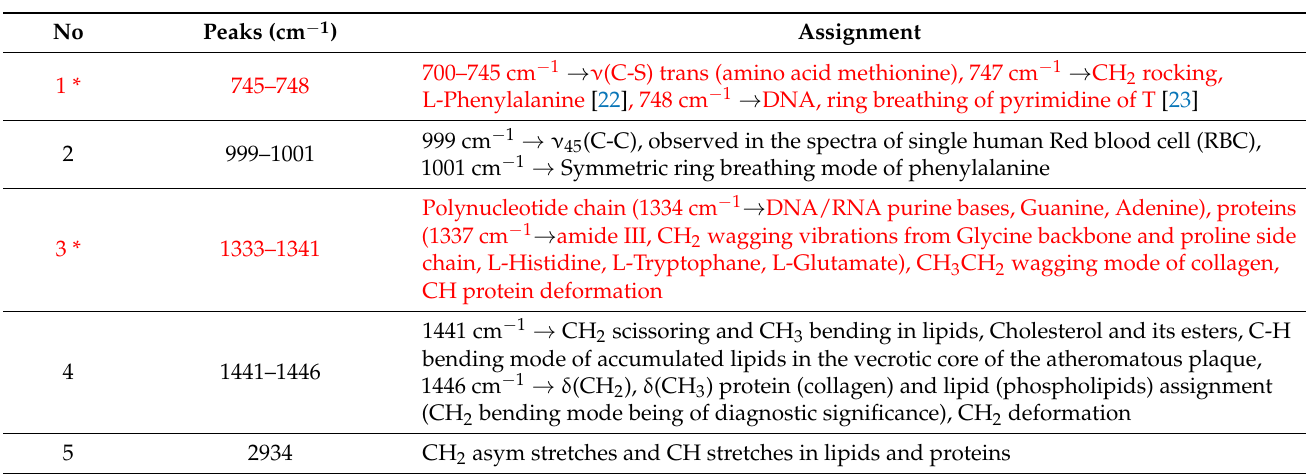
Table 6. Major Raman peaks found in BR1, BR2 under different temperatures. In red color and with an asterisk superscript the temperature dependent Raman peaks are presented.